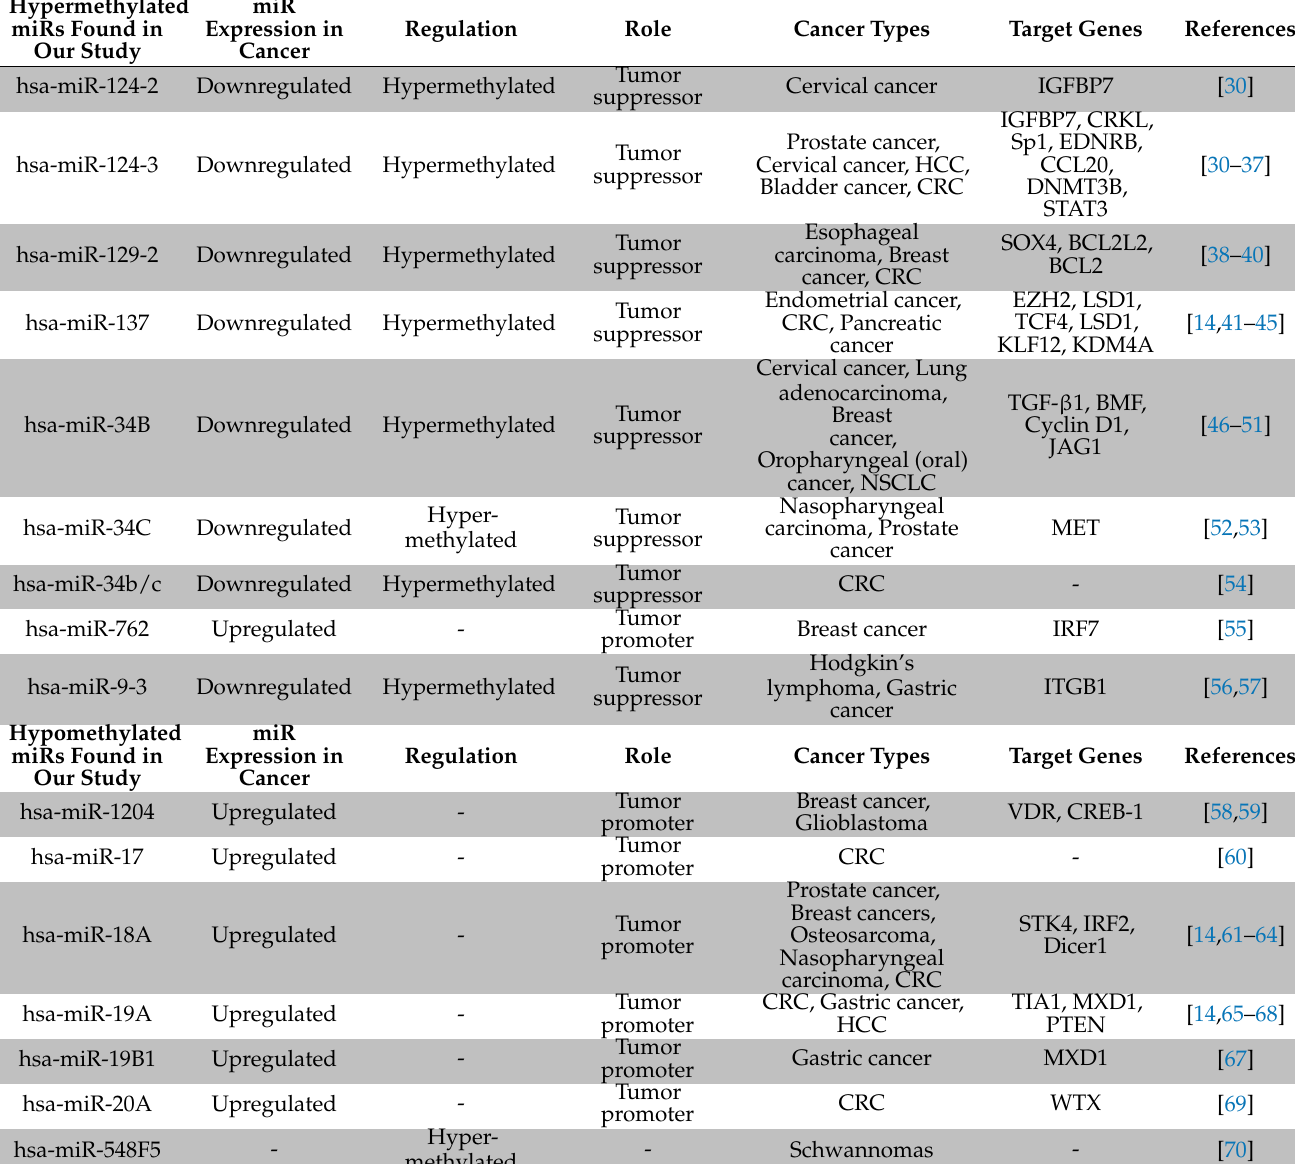
Table 3. Methylation status of 16 of the miR genes found in this this study and supporting expression and functional data from the current literature on the respective miRs. For two miRs found in this study, supporting literature is not yet available to the best of our